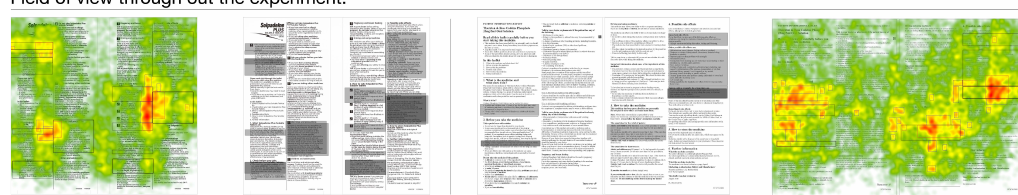
Figure 6. Field of view for all six tasks, the left side is sample 1 and the right side is sample 2. The correct answers for each task are boxed in the figures.